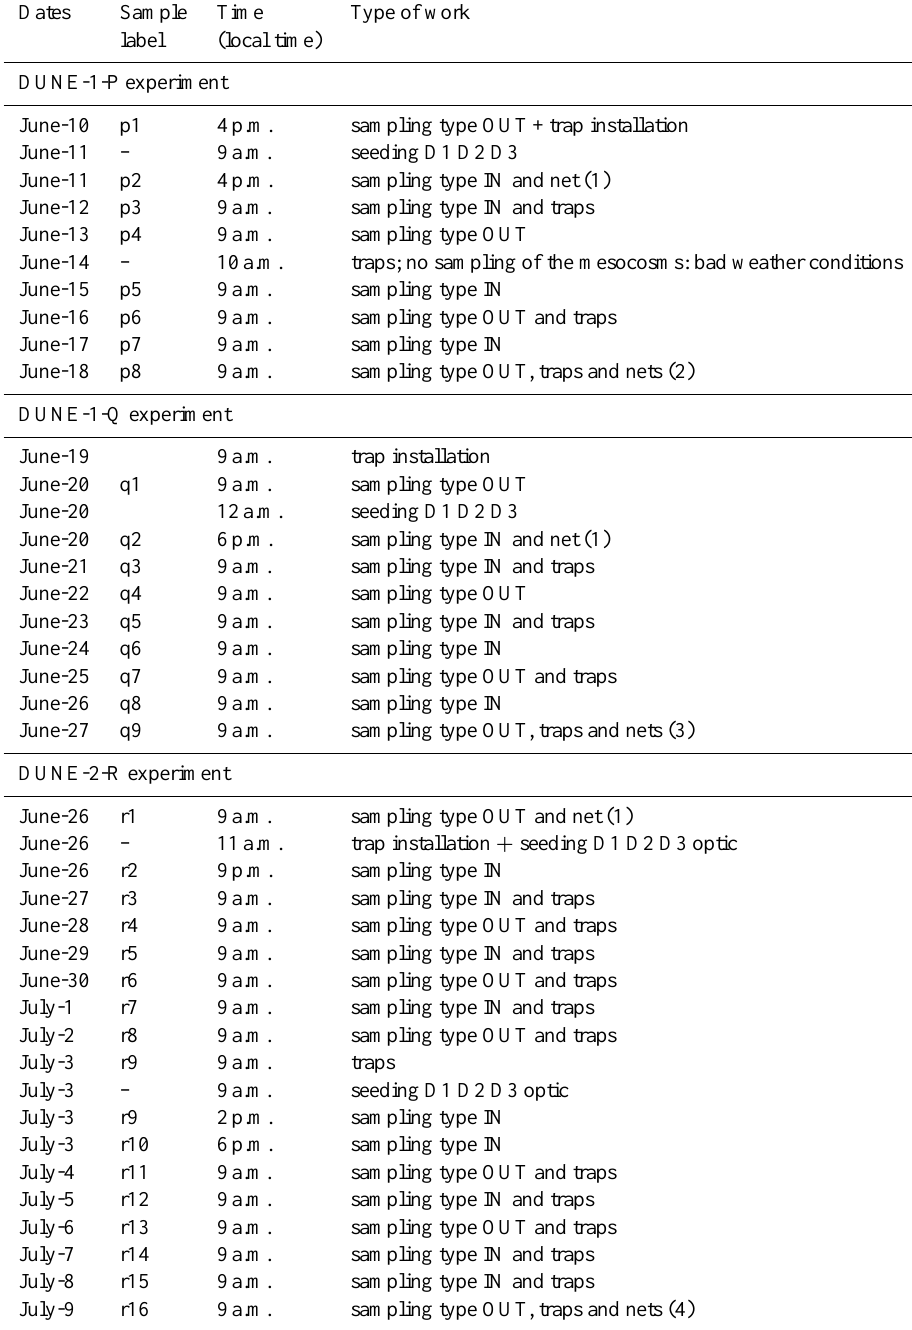
Table 3. Outline of sampling for all the DUNE dust seeding experiments. Sampling type OUT: all the mesocosms and a position at mid- distance between the two mesocosm clusters are sampled at the same depths. Sampling type IN: all the mesocosms are sampled. Time indicates the beginning of the sampling; the average total sampling time was less than two hours. Net sampling was performed at the beginning of experiments outside the mesocosms and both inside and outside after the last sampling of the